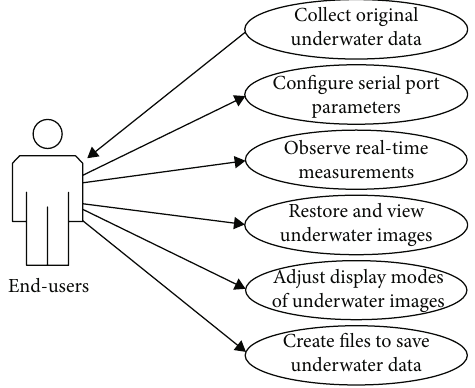
Figure 2: Use case